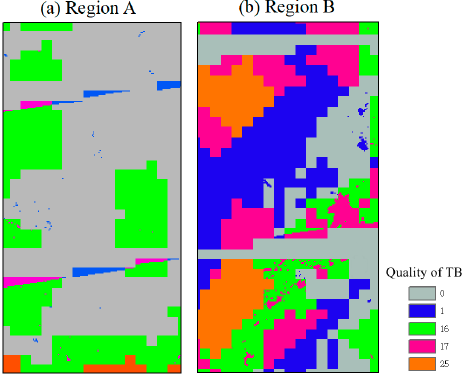
Figure 11. The quality flag of 1 km disaggregated brightness temperature (TB) data at V polarization for ( a ) region A (DOY = 2018, 71) and ( b ) region B (DOY = 2017, 342). (0: disaggregated TB data has acceptable quality. 1: unable to disaggregate TB data into cells; 16: significant levels of RFI were